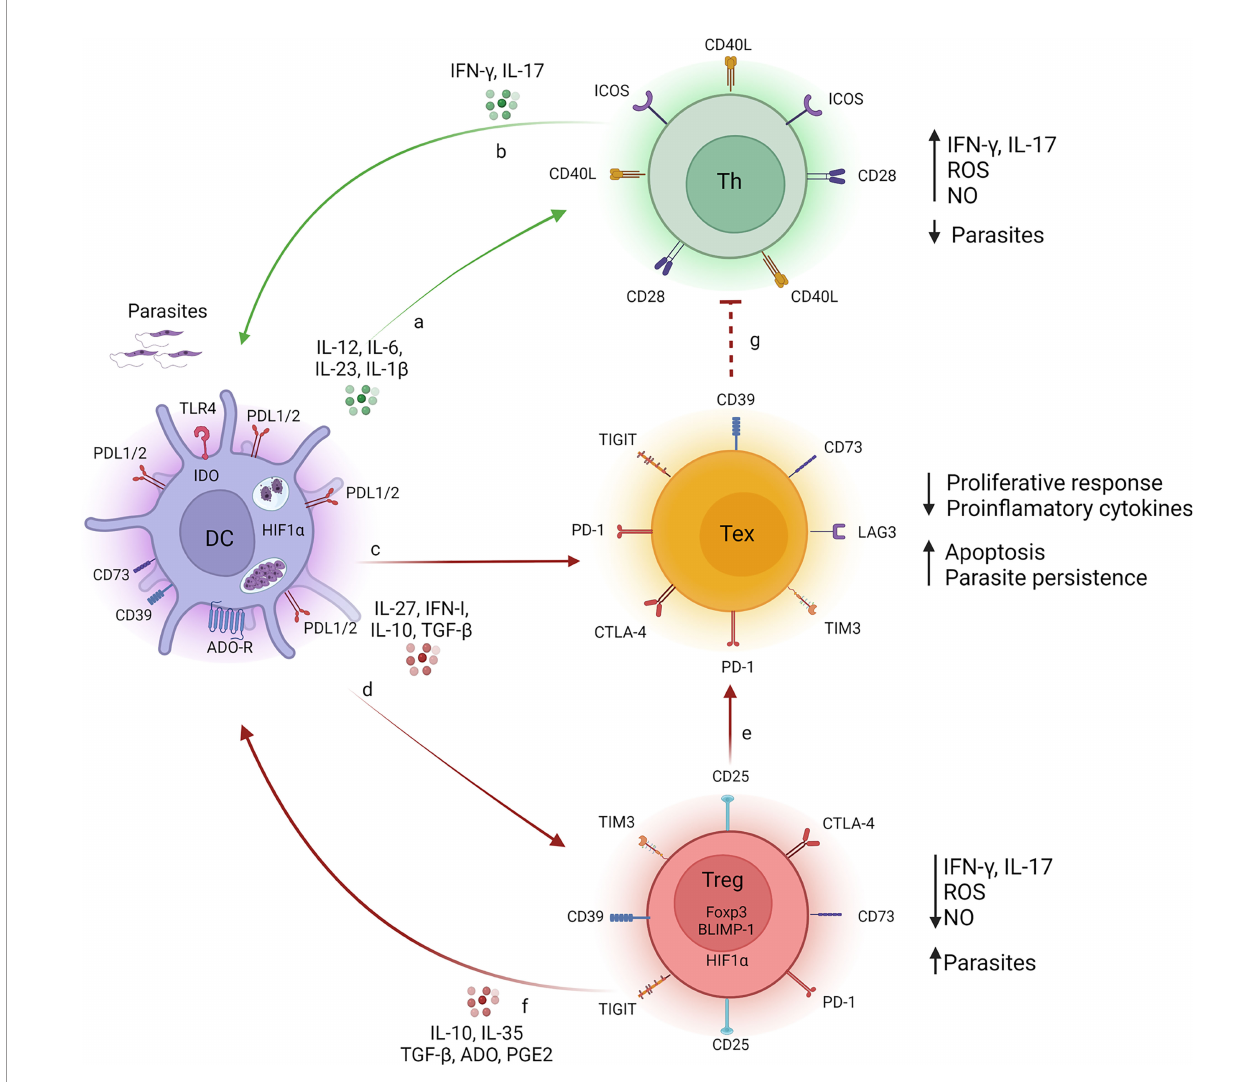
FIGURE 2 | T cell fate during Visceral Leishmaniasis. During infection with L. donovani or L. infantum , monocyte-derived cell (i.e. dendritic cell or macrophage) (purple cells) produce pro-in fl ammatory cytokines (IL-1 b , IL-6, IL-12 and IL-23), which act on naive T lymphocytes, targeting the cells to Th1 and Th17 subtypes (green cells), resulting in the production of IFN- g /IL-17 (A) . Secreted IFN- g and IL-17 promote the phagocytes microbicidal function of monocyte-derived cell trough the release of ROS and NO, reducing the parasite load (B) . The persistent presence of parasites induces a sustained and maintained production of regulatory molecules, such as TGF- b , IL-10, IL-27, PGE2, which promote exhaustion of T lymphocytes (yellow cells), a process characterized by increased expression of inhibitory molecules, such as CTLA-4, PD-1, TIM3, TIGIT, CD39, CD73, LAG-3, on T cell surface. As a consequence, the proliferative response and production of pro-in fl ammatory cytokines are suboptimal, mechanisms by which the parasite uses to survive in the host-vertebrate (C) . Such regulatory molecules in fl uence the inhibitory receptors on the surface of Treg cells (red cells) impacting on their both differentiation and suppressive function (D) and upon DCs functions (F) . Such factors repress the protective immune response mediated by IFN- g /IL-17 and ROS/NO (G) . Tregs also respond to regulatory molecules, and contribute to the exhaustion process of T lymphocytes by sustaining the release of regulatory mediators (TGF- b , IL-10, IL-35, PGE2 and adenosine) in the microenvironment and maintaining high levels of inhibitory molecules on the surface of exhausted T lymphocytes (E) . Together, these signs favor the persistence of the parasite. Legends: green arrow (induction of effector response), red arrow (induction of suppressor response), red dotted arrow (inhibition of effector response). Created with BioRender. com (Agreement number: